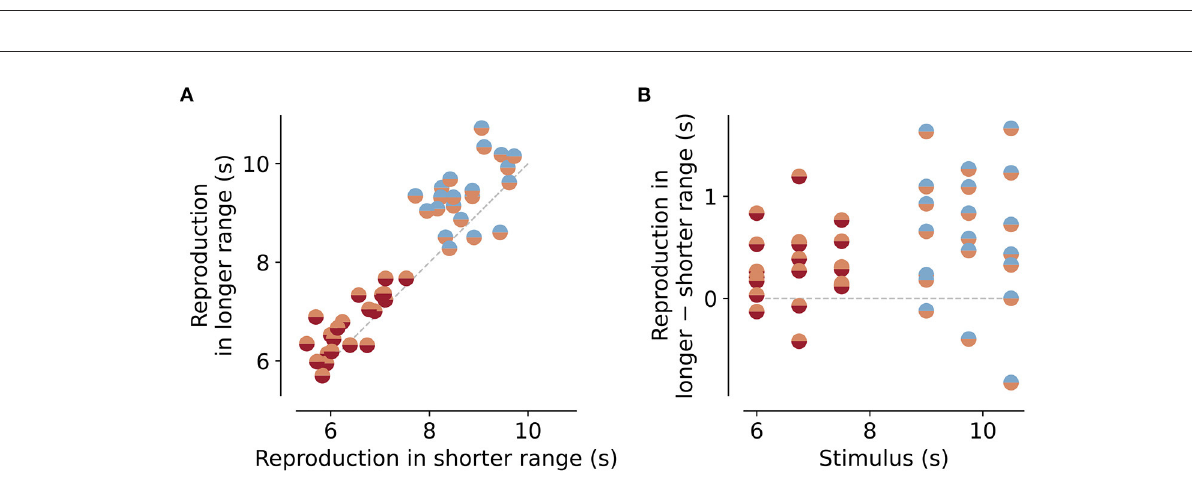
FIGURE3 Reproductions for the same stimuli embedded in different stimulus ranges. (A) Reproduced values for stimuli that are part of the short and intermediate ranges (orange/red markers) or intermediate and long ranges (blue/orange markers). Data points lie above the equality line (gray dashed line). Therefore, reproductions of the same stimulus are usually bigger when embedded in a longer range than in a shorter one. This is even better visible in the differences between reproductions (B) . Gray dashed line marks no